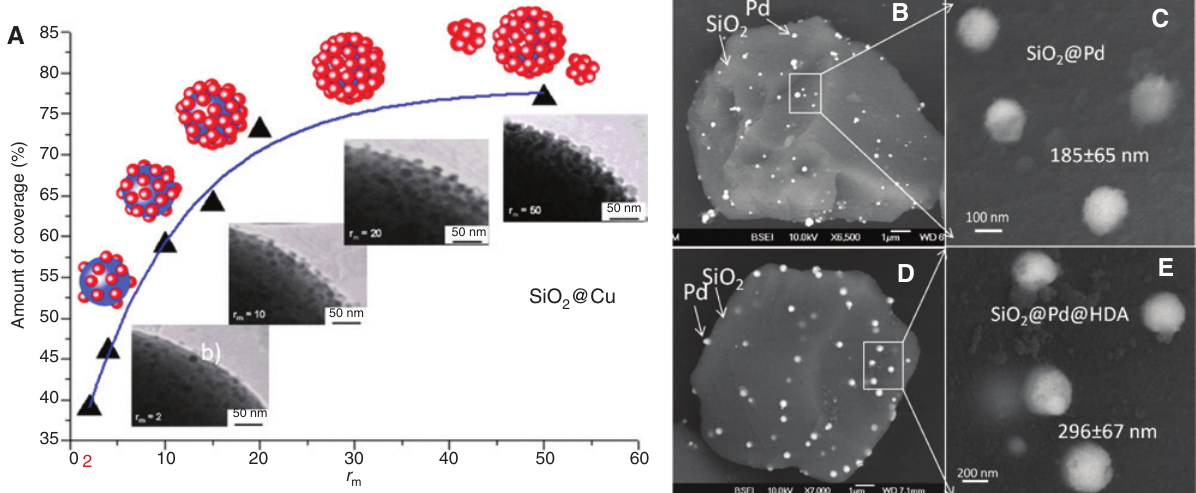
Figure 10: Examples of inorganic (A–C) or hybrid (D, E) nanostructures. (A) Silica surface decorated with monodispersed Cu NPs, with the surface coverage increasing when the mass ratio ( r ) between Cu precursor and silica is increasing. Reprinted with permission from m Marre S, Cansell F, Aymonier C, Nanotechnology 2006, 17, 4594–4599 [32], Copyright 2006 IOP Science. (B, C) Silica surface decorated with large spherical agglomerates ( ~ 200 nm) made of small ( ~ 8 nm) Pd NPs. (D, E) Silica surface decorated with larger more uniform spherical agglomerates ( ~ 300 nm) made of small ( ~ 8 nm) Pd NPs in the presence of an amine-type surfactant. Reprinted with permission from